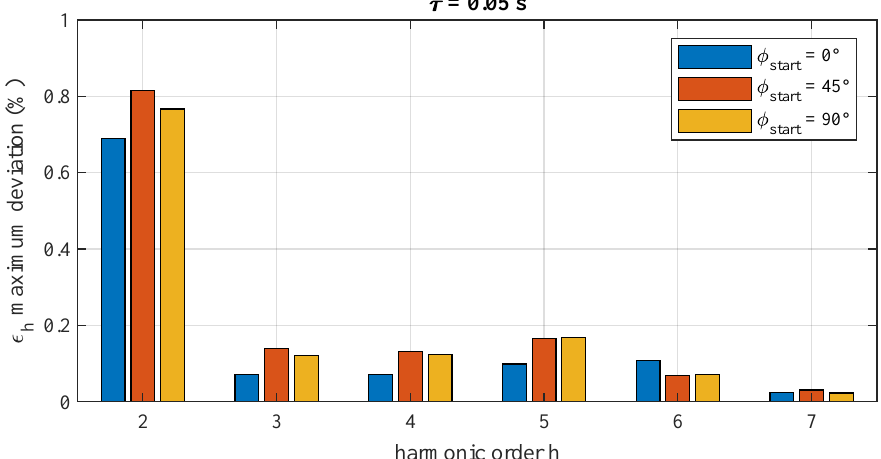
Figure 5. VT B : comparison among the maximum error deviation from the 2nd to the 7th harmonic when the DC disturbance of A = 2% and τ =0.05 s occurs at φ start = 0°, φ start = 45° and φ start =